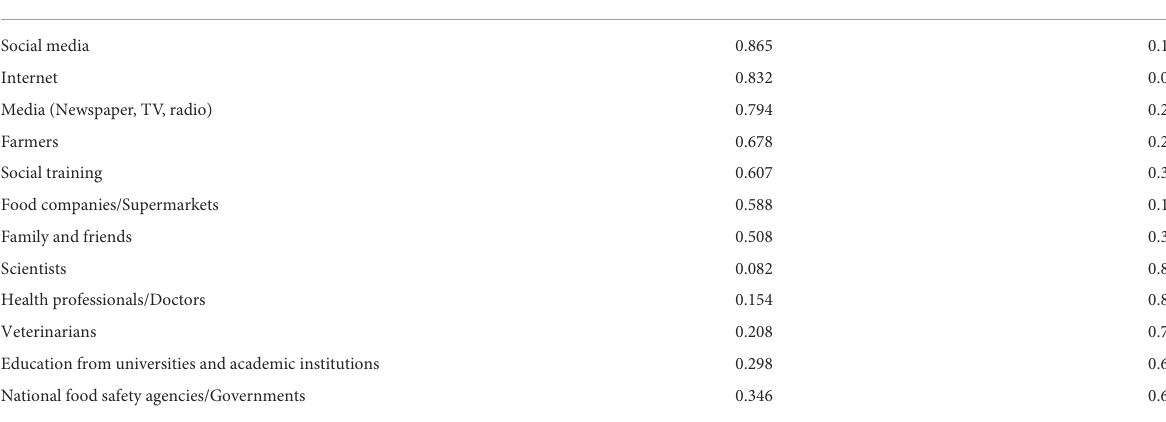
TABLE 3 The pattern matrix of exploratory factor analysis of information sources.